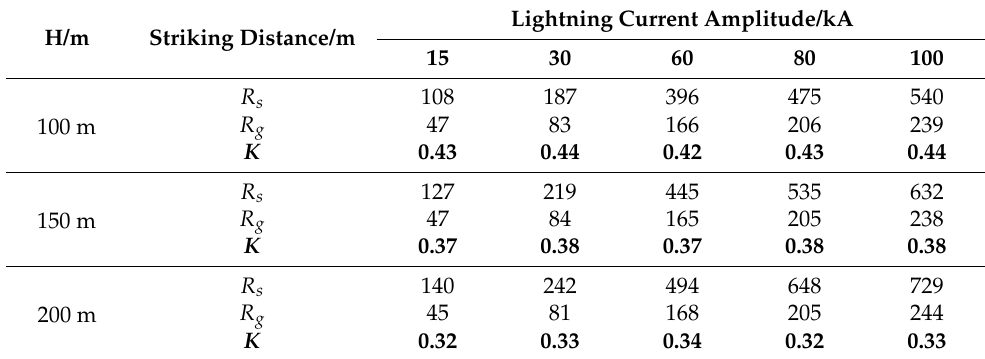
Table 2. Lightning striking distance to the ground and the striking distance coefficients. Lightning Current H/m Striking Distance/m